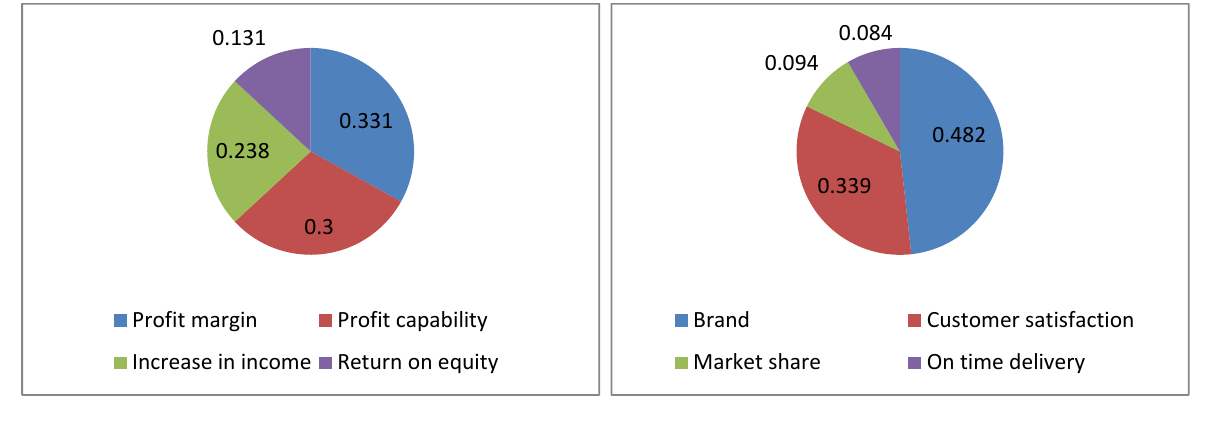
Fig. 1. The summary of ranking for financial perspectives Fig. 2. The summary of ranking for customer perspectives